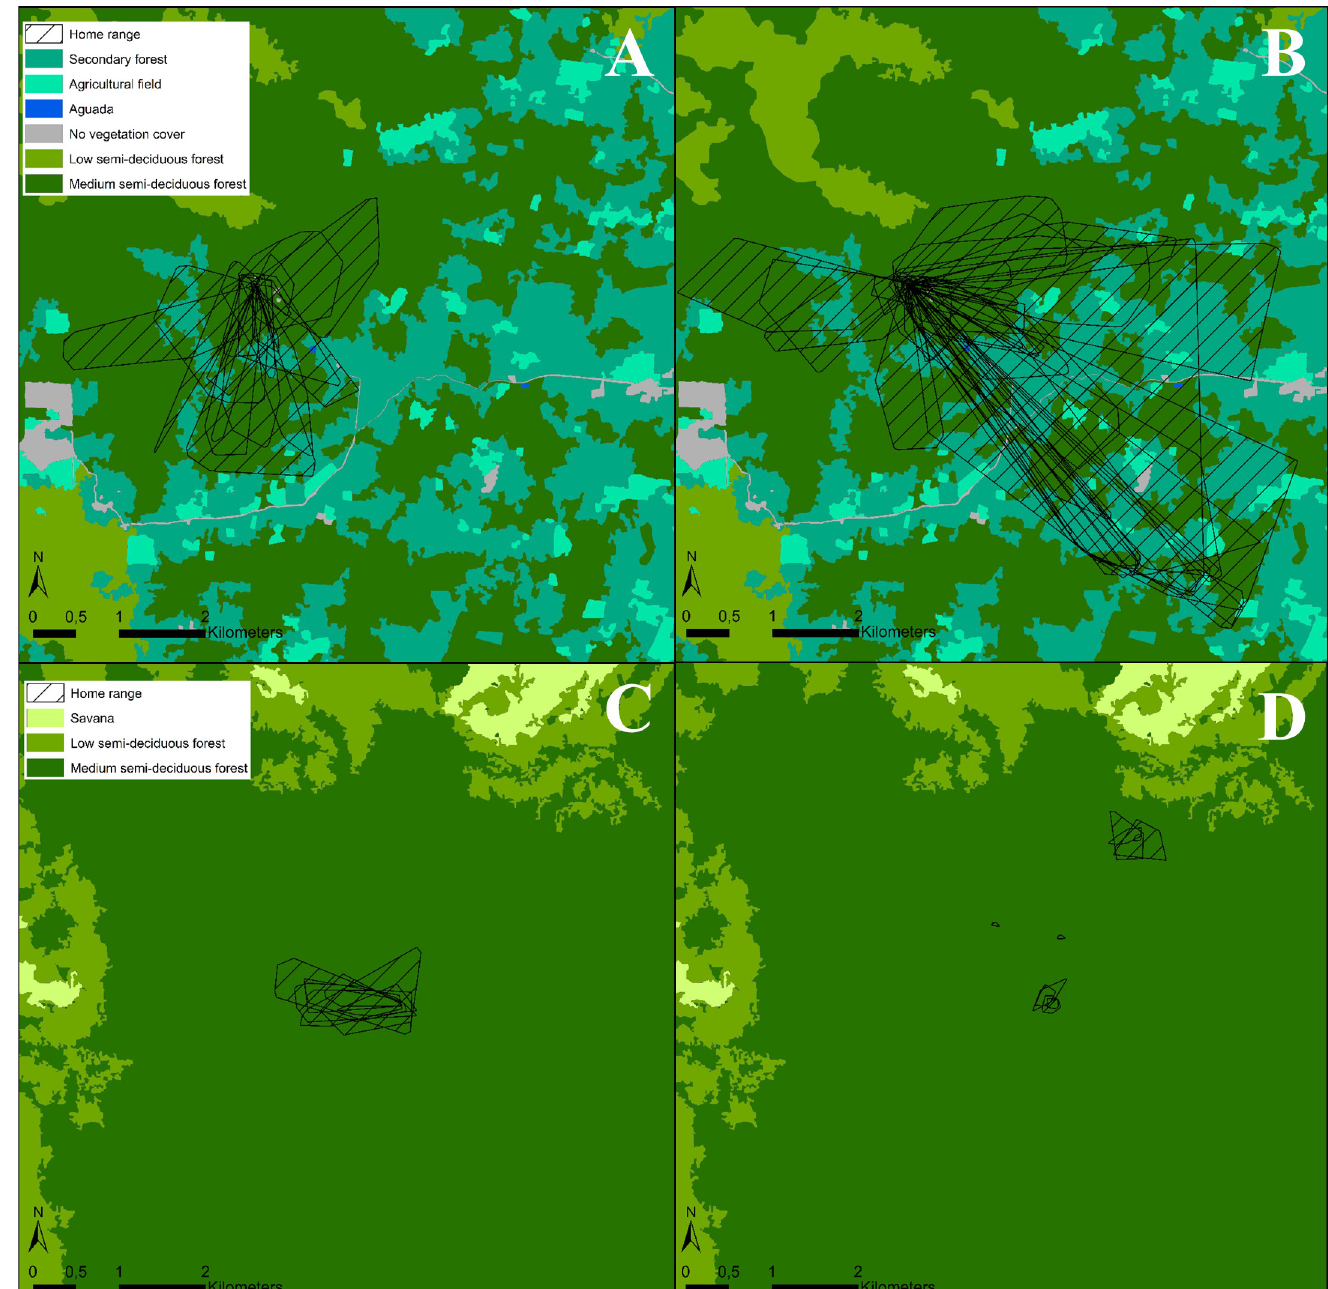
Fig 3. The home ranges per night flight of two females (A) and four males (B) in the study site of Hormiguero and two female (C) and two males (D) in the study site of